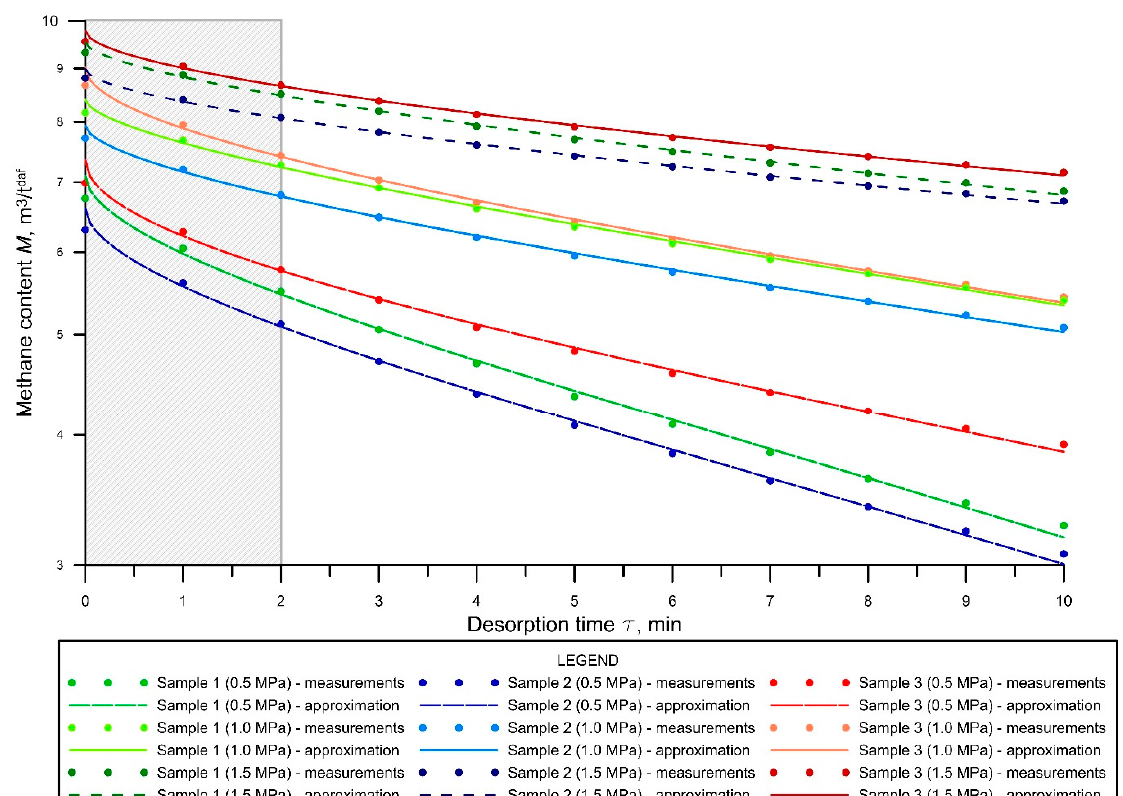
Figure 2. Examples of curves fitted for the desorption results for three samples saturated by methane at pressures 0.5 MPa, 1.0 MPa and 1.5 MPa, respectively.